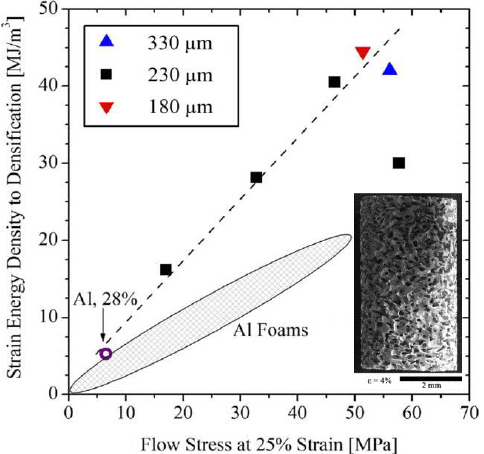
Figure 1. The comparison of the plastic energy absorption capacity between the conventional Al foams and the Vit106 metallic glass (MG) foams with pore sizes of 180 µm, 230 µm and 330 µm, where the inset shows an MG foam (pore size 230 µm) at a nominal strain of 4%. Adapted from [7] with copyright permission from Elsevier, 2005.